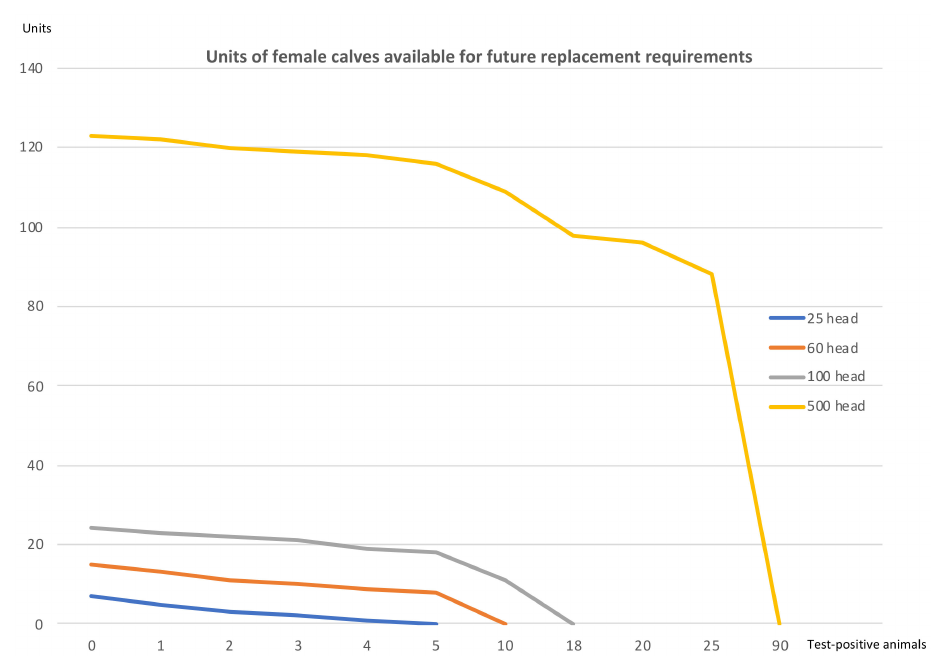
Figure 4. Units of female calves available for future replacement requirements in 25, 60, 100 and 500 head of